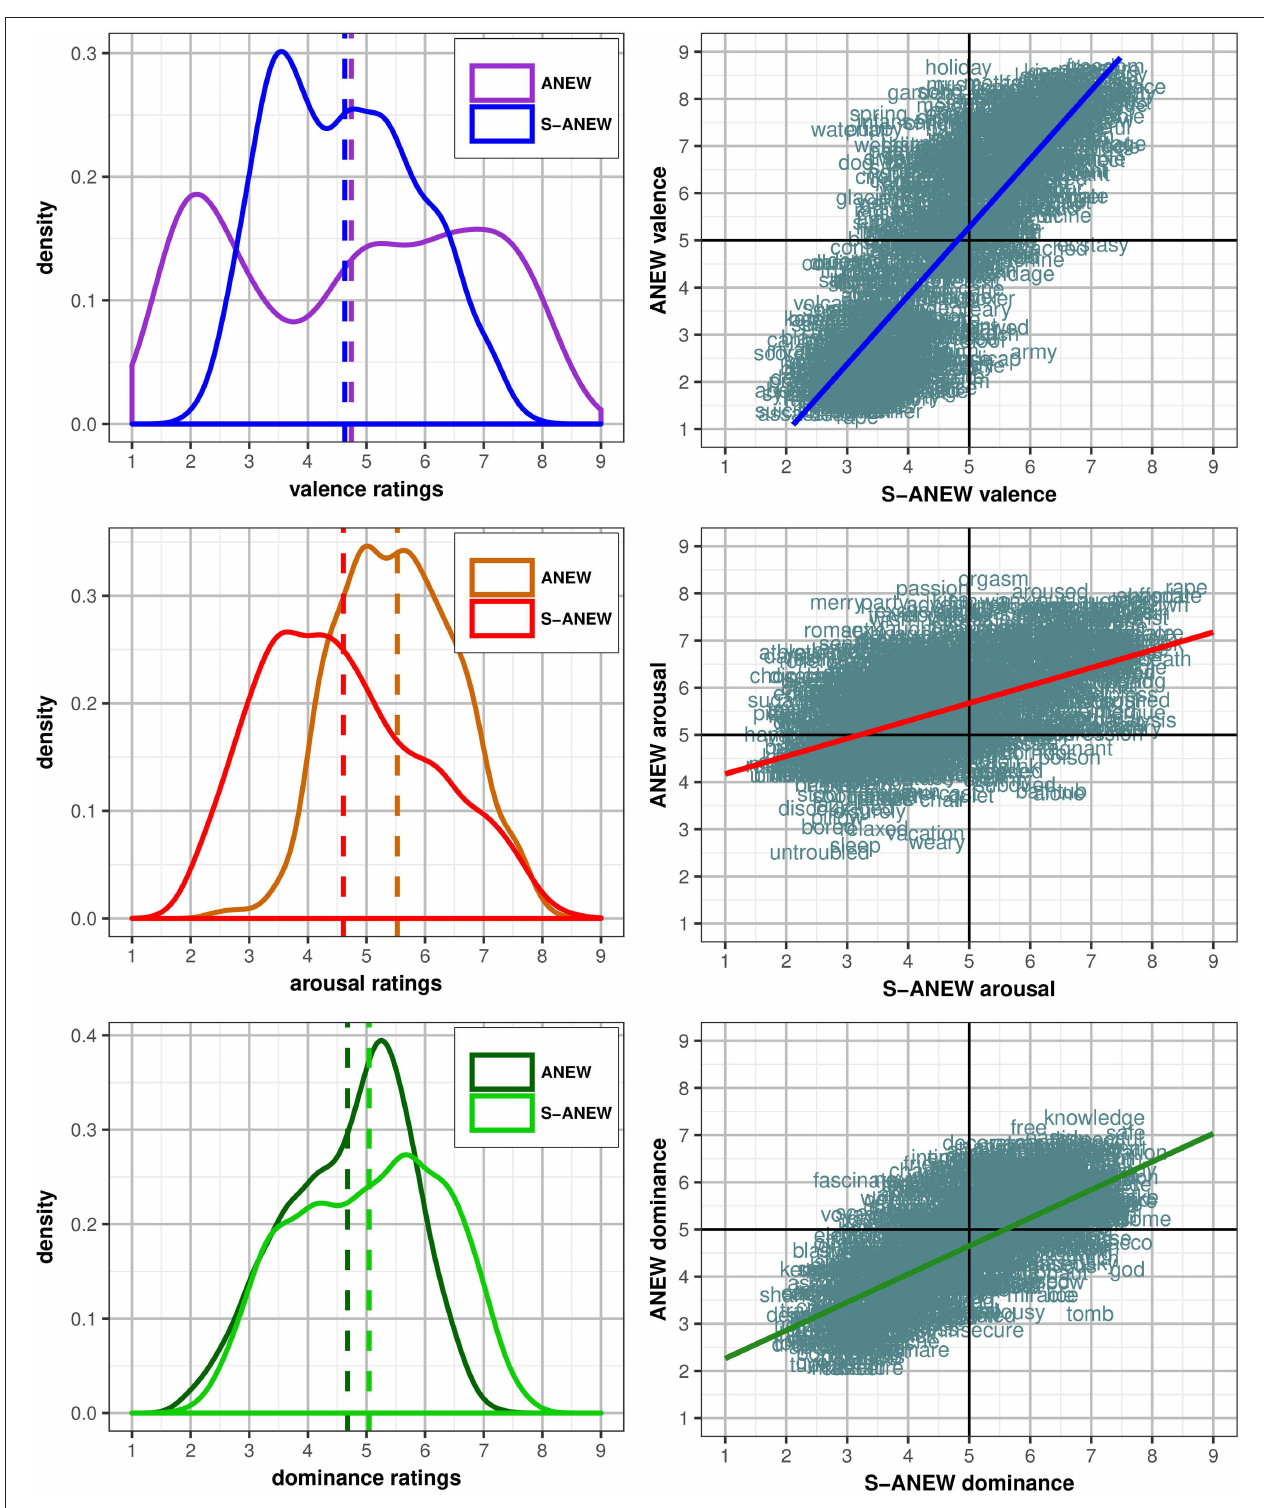
FIGURE 2 | ANEW and Spanish S-ANEW comparison of valence (Up) arousal (Center) , and dominance (Bottom) ratings (plot density bandwidth adjust set to 1).